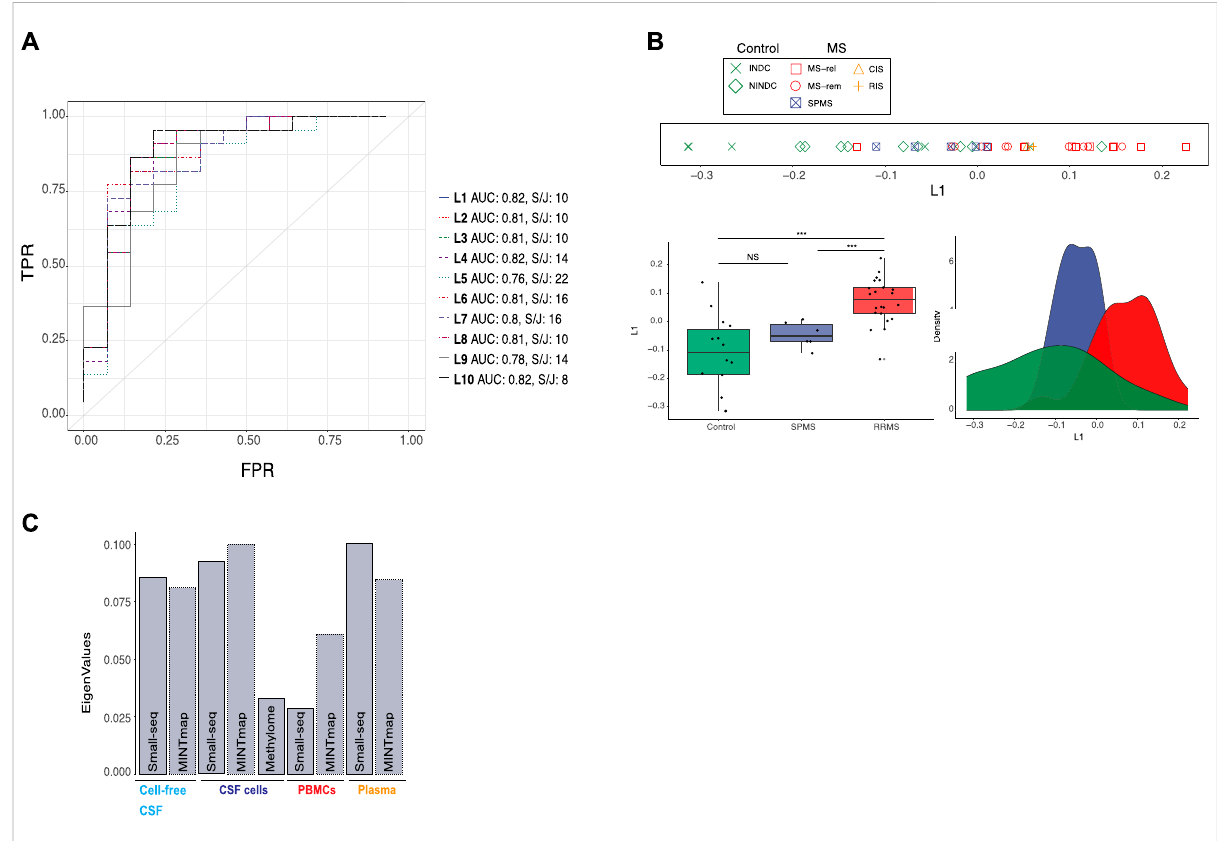
FIGURE 2 Integration of omics data from cellular and fl uid sources separates RRMS from controls and SPMS. (A) Multiple co-inertia analysis (MCIA) methodwasusedforsimultaneous,unsupervisedintegration.Atotalof10latentvariables(L1-L10),illustratedwithdifferentcoloursanddashedlines, were evaluated using Area Under the Receiver Operating Characteristics (AUROC) analysis and k-means clustering (k = 2) followed by split and join method as indicated by “ AUC ” and “ S/J ” , respectively. TPR: true positive rate, FPR: false positive rate (B) Separation of controls (green), secondary progressive multiple sclerosis (SPMS, blue) and relapsing – remitting MS (RRMS, red) based on L1, was evaluated with line, density and boxplots as well as Wilcoxon signed-rank test (***: p -value < 0.001. NS: not signi fi cant). In the line plot MS subtype: relapse (MS-rel), remission (MS- rem) and secondary progressive (SPMS), control subtype: in fl ammatory (INDC) and non-in fl ammatory neurological disease controls (NINDCs) and clinicallyorradiologicallyisolatedsyndrome(CISandRIS)aredistinguishedbycolourandshape. (C) ContributionofsmallRNAsderivedbytheSmall- seq pipeline, Mintmap and methylome derived data to